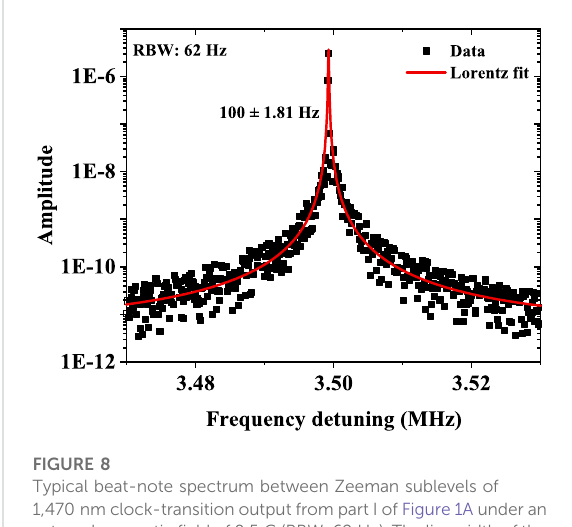
FIGURE 8 Typical beat-note spectrum between Zeeman sublevels of 1,470 nm clock-transition output from part I of Figure 1A under an external magnetic fi eld of0.5 G (RBW:62 Hz).The linewidth ofthe experimentaldata(blacksquaredots)isobtainedbyusingthe Lorentzian fi t (red